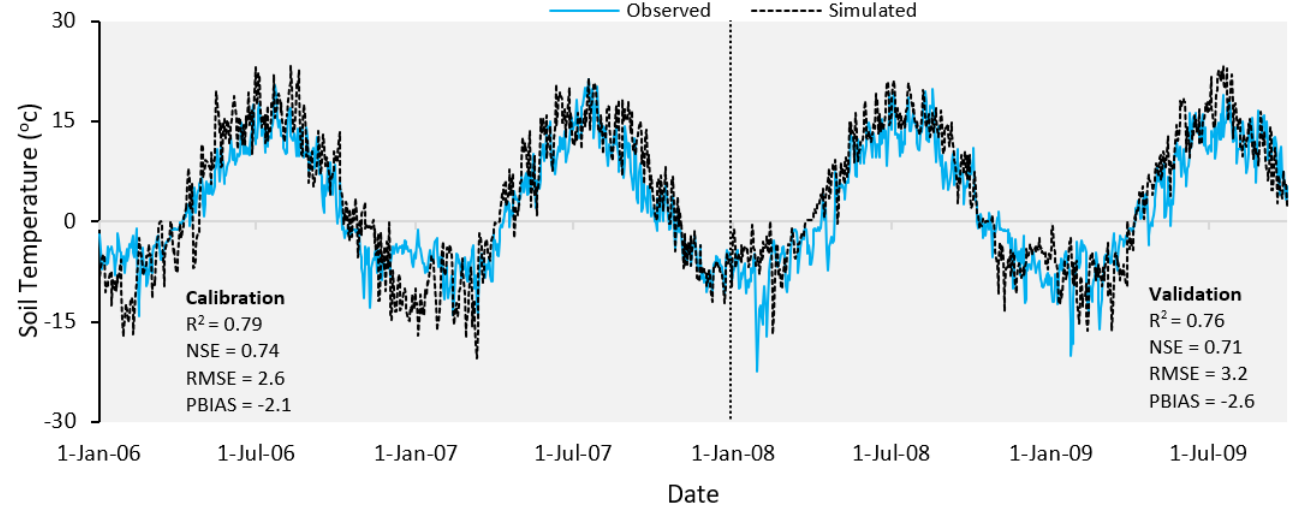
Figure 8. Predicted and observed daily soil temperature in the calibration and validation periods.